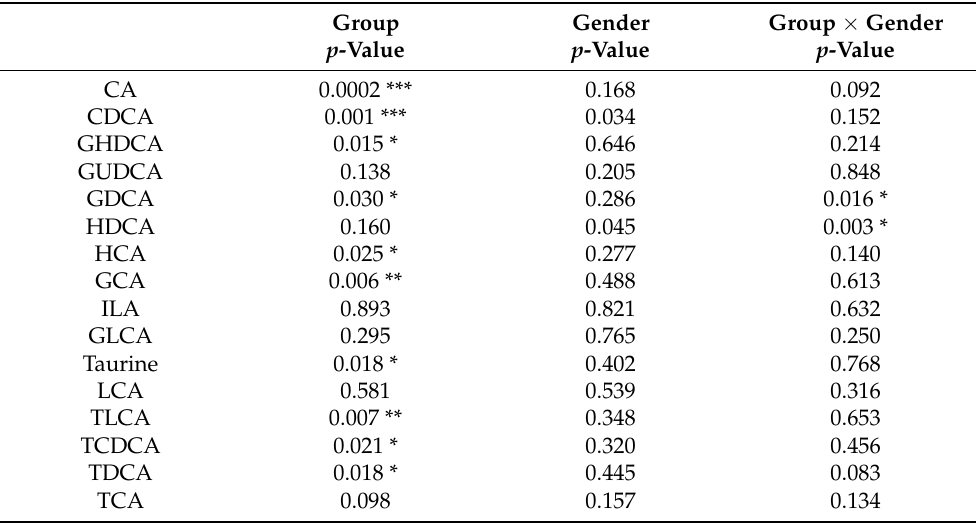
Table A1. Significance probability ( p ) values for bile acid metabolites between healthy control,